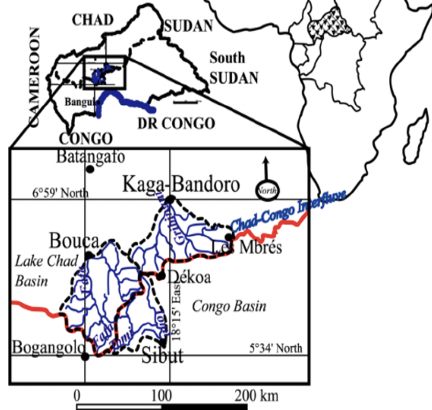
Figure 1. Location of the 3 studied catchments (Fafa at Bouca, Tomi at Sibut and Gribingui at